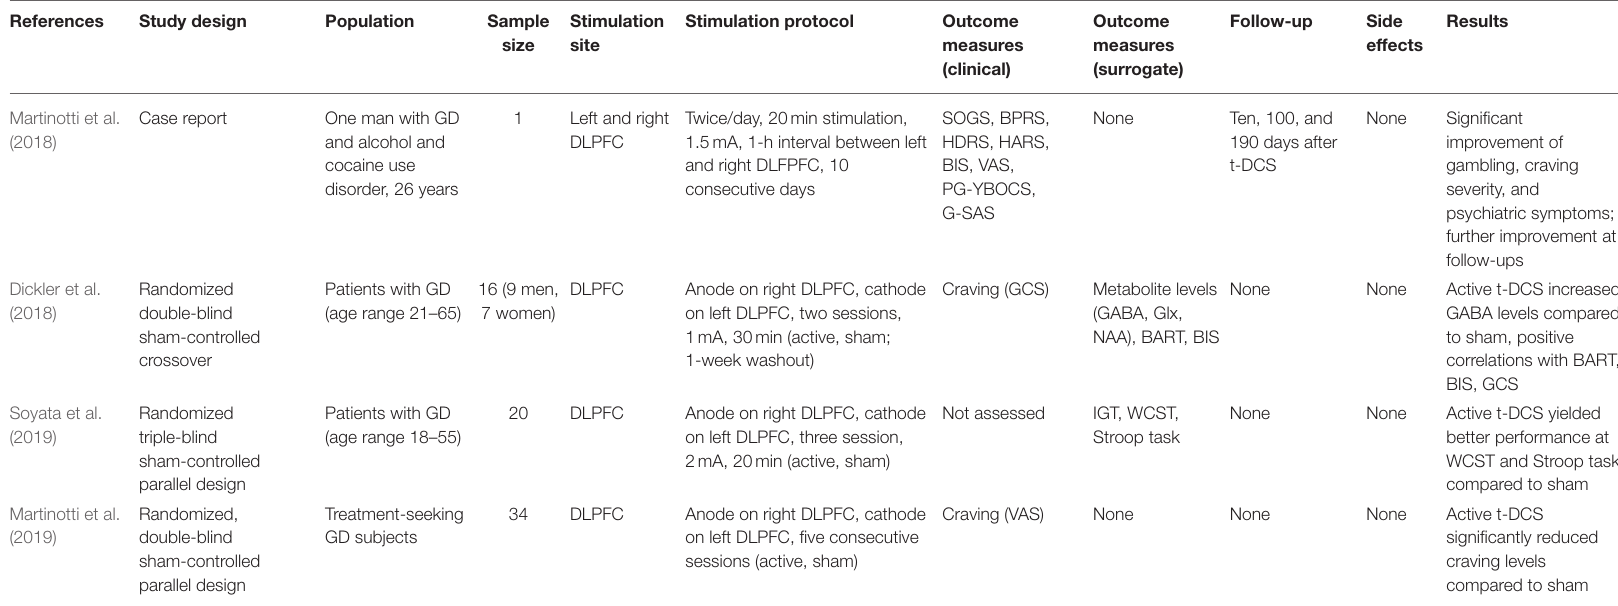
TABLE 2 | Overview of t-DCS studies included in the